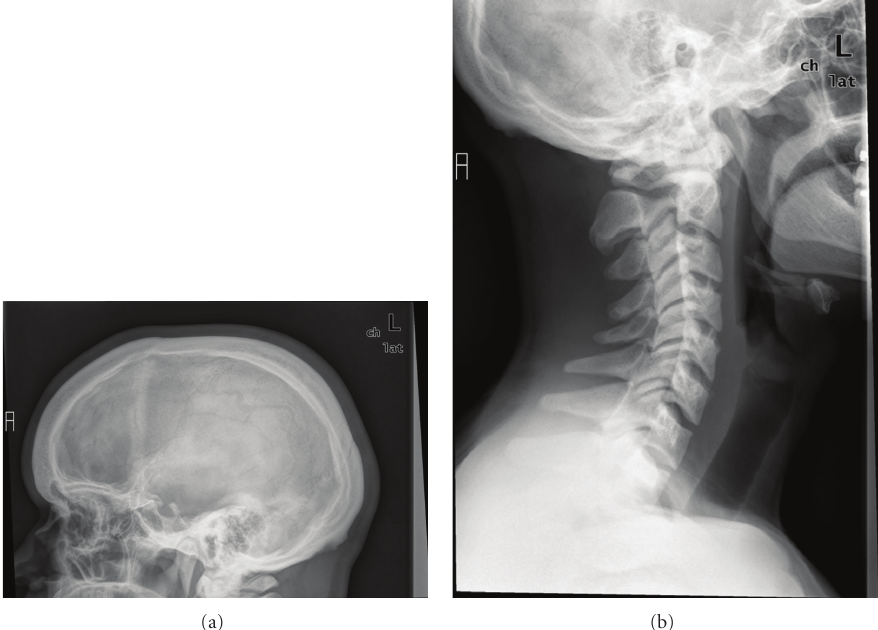
Figure 2: Skull films. Patient’s skull films are shown. They are significant for a thickened calvarium and prominent thickening of the skull at the base with a normal and symmetric density. No narrowing of the intervertebral spaces and no fractures are